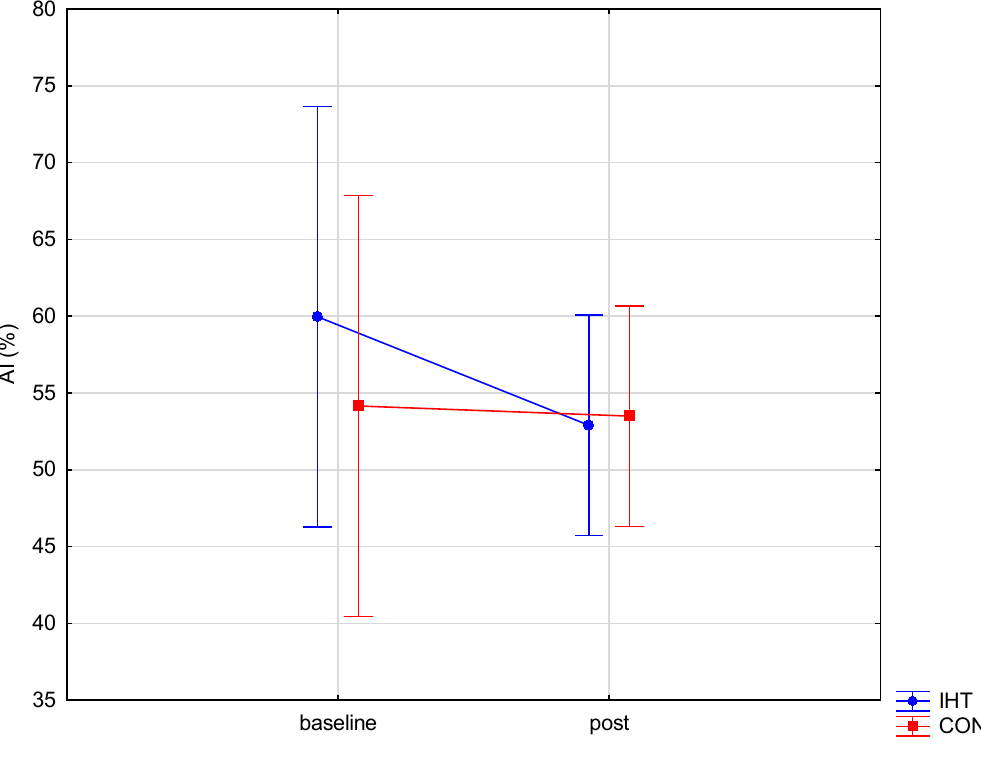
Figure 3. Red blood cell aggregation index (AI) in rowers training in the hypoxia (intermittent hypoxic training, IHT) and normoxia (control, CON) conditions before and after the intervention.